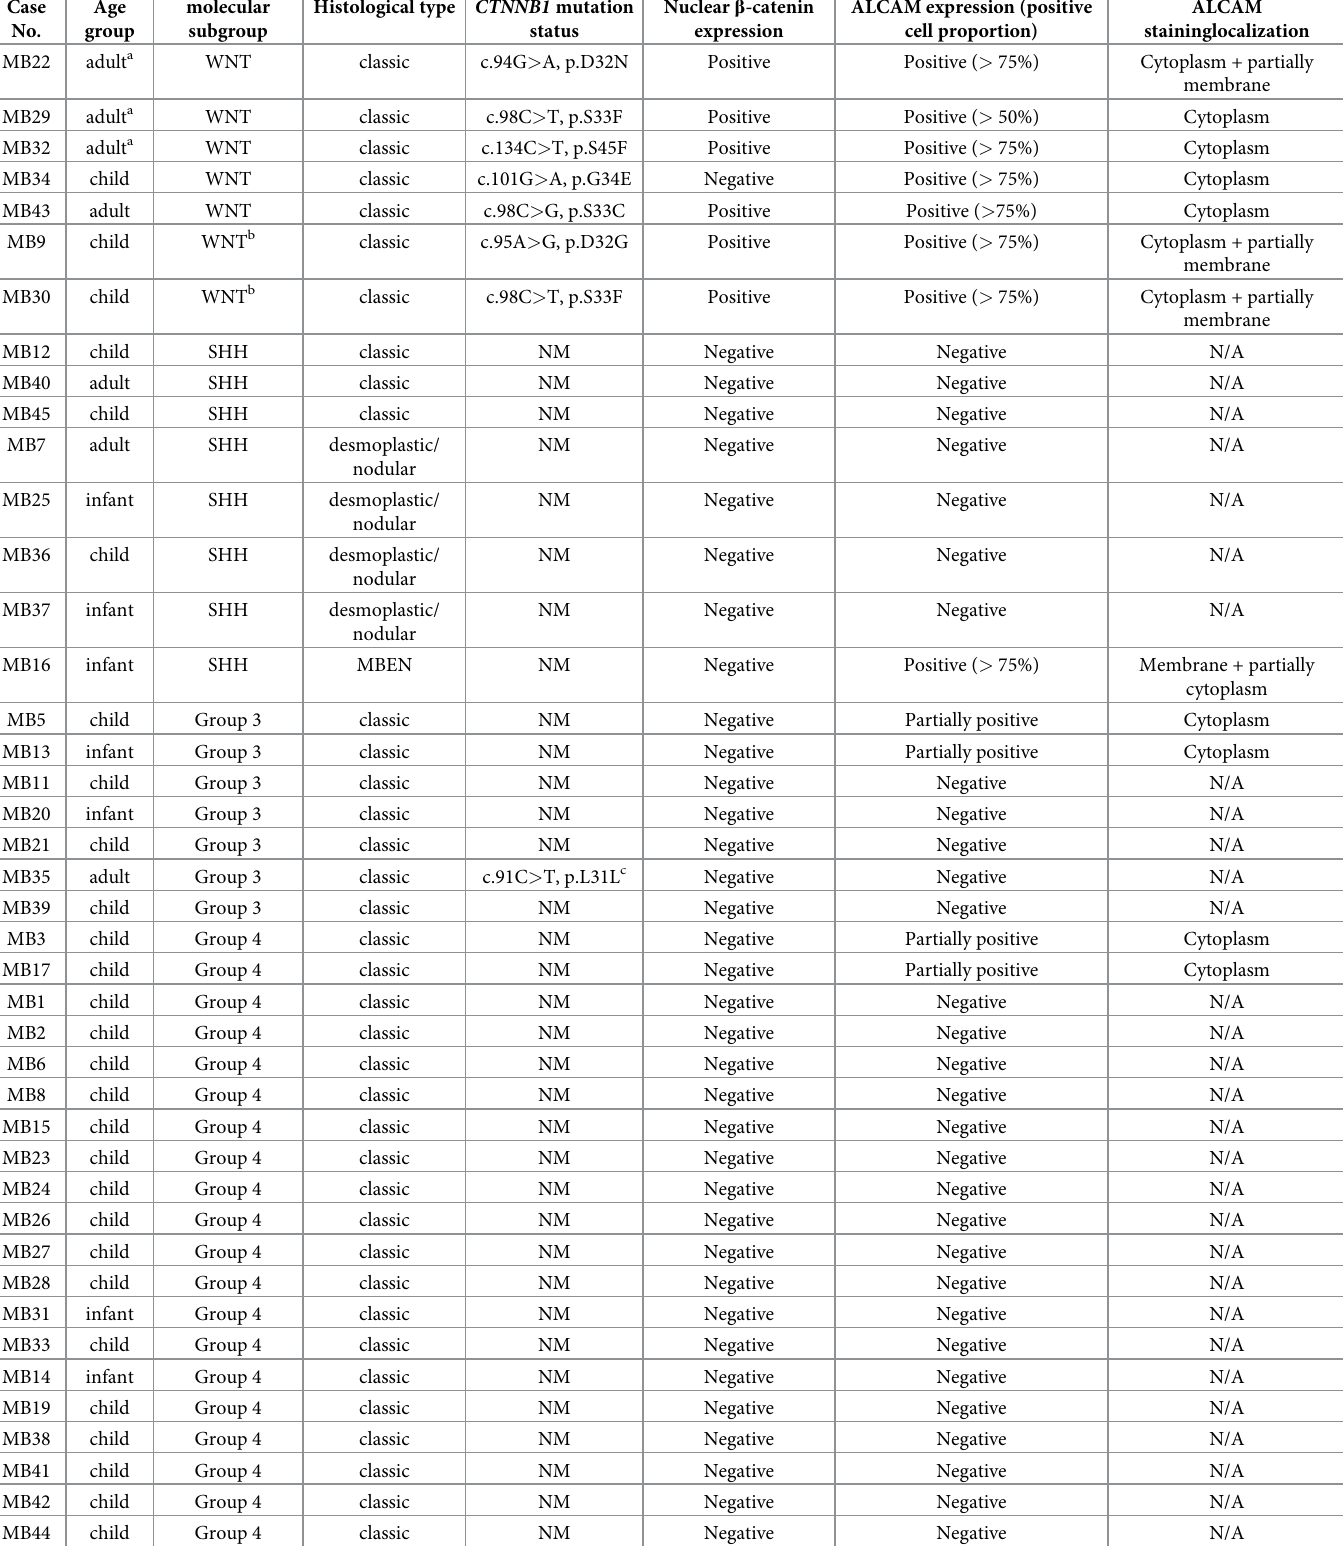
Table 2. Overview of clinicopathological/molecular characteristics and ALCAM expression in the MB cases examined. Case